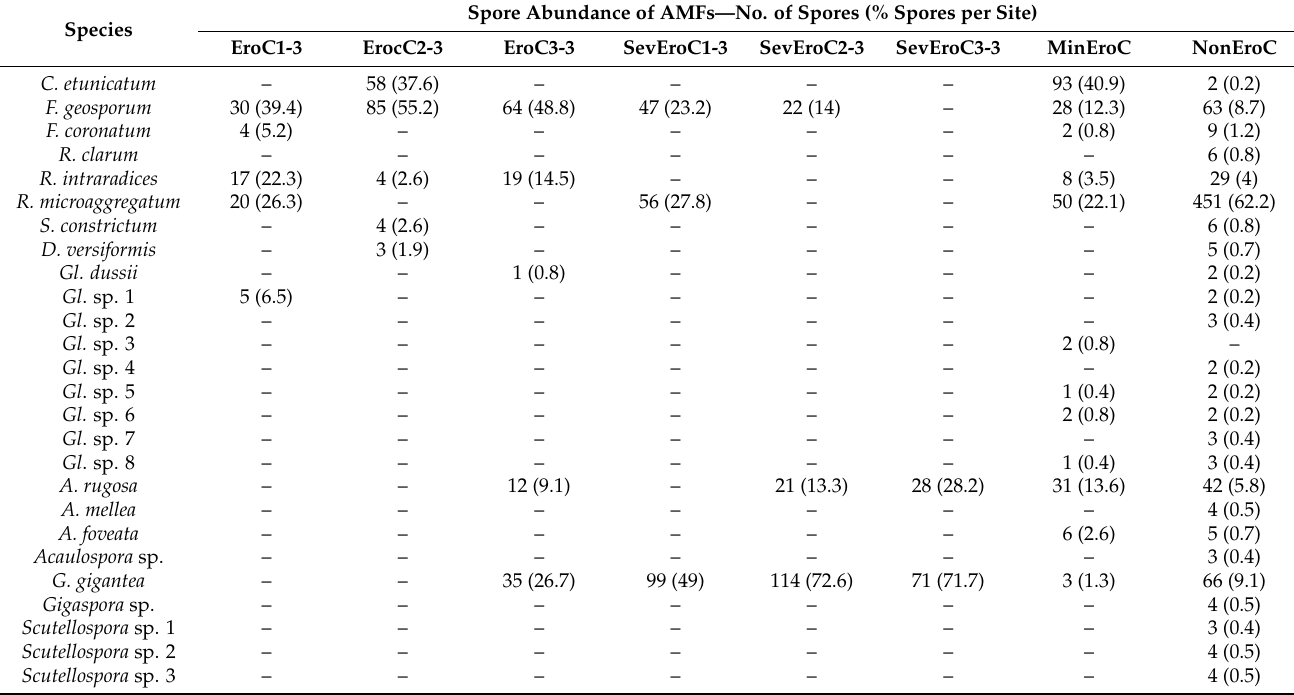
Table 3. Spore abundance of AMF species found at field sites with coffee.